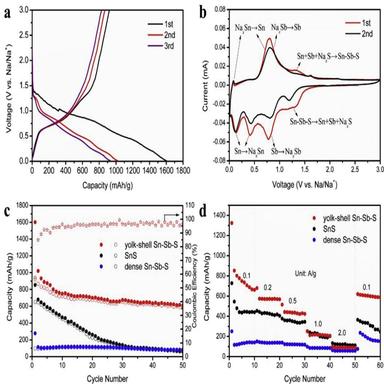
Electrochemical performance for SIBs. a) The initial three charge-discharge voltage profiles of the yolk-shell Sn-Sb-S electrode at current density of 0.1 A/g. b) CV curves of the yolk-shell Sn-Sb-S electrode measured in the potential range of 0.01e3.0 V (vs. Na/Naþ) at a scan rate of 0.1 mV/s c) Cycling performances of the yolk-shell Sn-Sb-S, singlephased SnS and dense Sn-Sb-S anodes, and coulombic efficiency of yolk-shell Sn-Sb-S anode. d) Rate capabilities of the yolk-shell Sn-Sb-S, single-phased SnS and